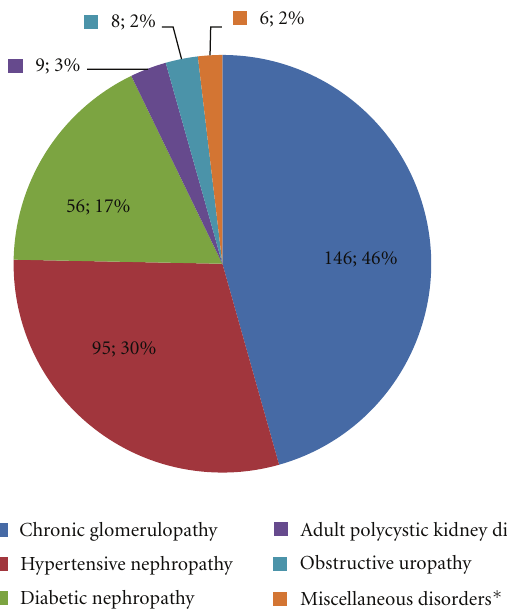
Figure 1: Chart showing causes of CKD in study sub- jects. ∗ Miscellaneous disorders: Analgesic nephropathy(1), Multi- ple myeloma(1), chronic pyelonephritis(1), inadvertent nephrec- tomy(1), sickle nephropathy(1), and indeterminate(1).